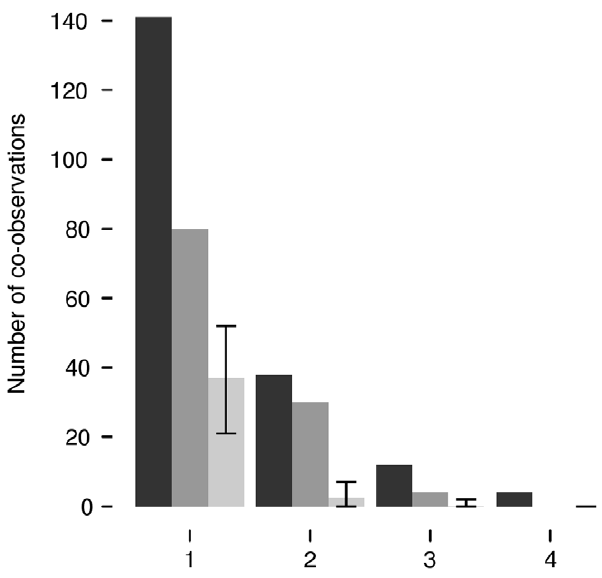
Figure 3. Number of other bats (1, 2, 3. or 4) actually found near a focal bat or expected by chance, summarized over all roosts and tracking sessions. First cluster of bars on x-axis: Black bar: number of occasions another bat was found in the same time window (n=141), dark grey bar: number of occasions where this other bat also had the same compass bearing ( 6 3 u ; n=80), light grey bar: the random number of occasions another bat would be expected in the same time window and with the same compass bearing (n=37.01 range 21 to 52). Group foraging occurred significantly more often than expected by chance. Additional clusters of bars: actual numbers of occasions that 2, 3 or 4 other bats were near in time or in time and space and the corresponding random expectations. Error bars indicate the minimum and maximum found with randomization through bootstrapping. See text for